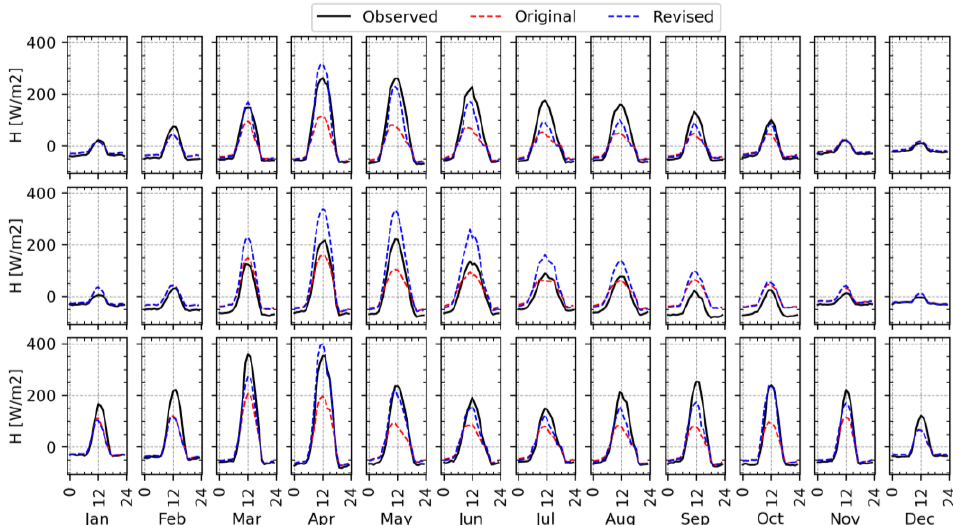
Figure 4. Time-averaged diurnal variations in the observed and simulated sensible heat flux by the original and the revised parameterization at Deciduous Broad Leaf Forest (DBF) sites. The top row corresponds to the Hainich site in Germany (DE-Hai), the middle row to the Soroe site in Denmark (DK-Sor), and the bottom row to the Morgan Monroe State Forest site in the USA (US-MMS).